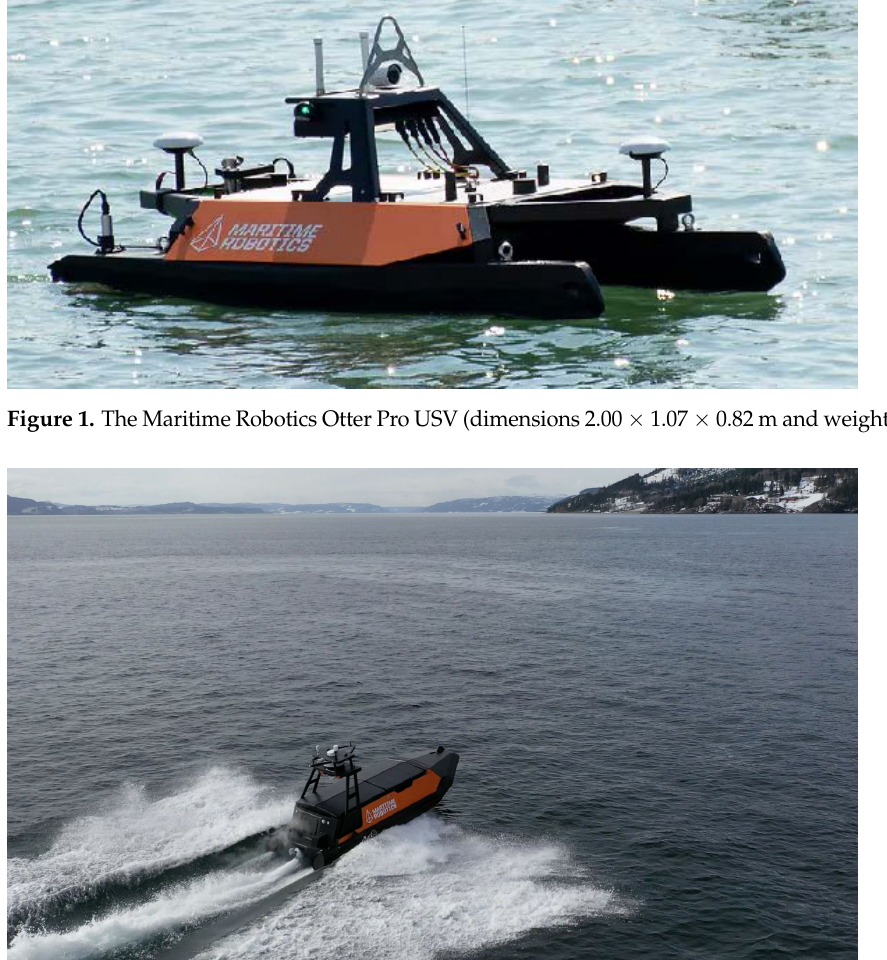
Figure 2. The Maritime Robotics Mariner USV (dimensions 5.95